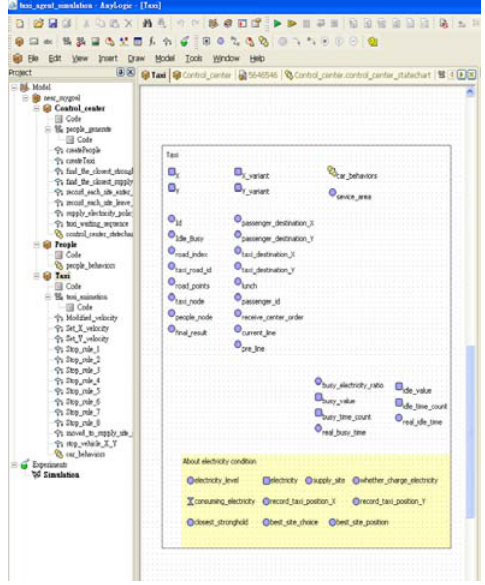
Figure 13(a). “The agent attributes of electric-taxi DAR operation system”.